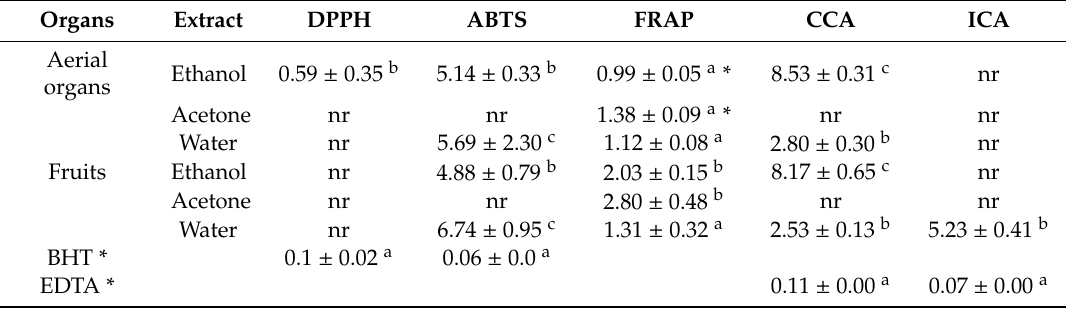
Values represent the mean ± standard error of mean (SEM) performed six times (n = 6). For the same column, di ff erent letters are significantly di ff erent (Multiple Comparisons of Means: Tukey Contrast, 95%